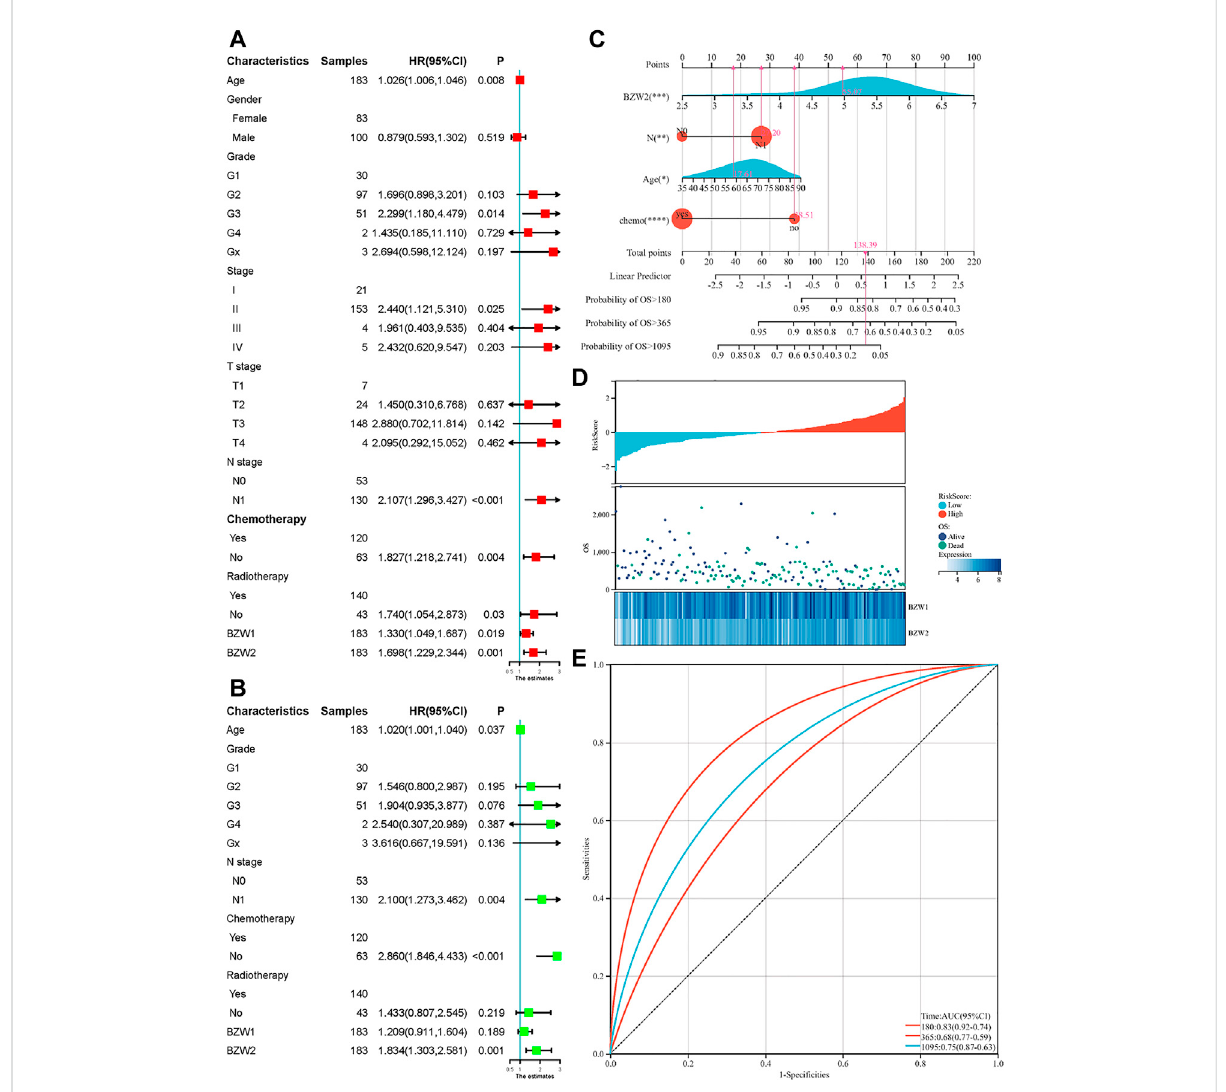
FIGURE 5 Univariate (A) and multivariate (B) cox regression for OS of PAAD patients. A nomogram was established to predict the OS of PAAD patients based on the independent predictors (C). Heatmap and scatter plot of risk score, survival time and status of all samples (D). ROC curves of the nomogram to predict 180-, 365- and 1095-day survival